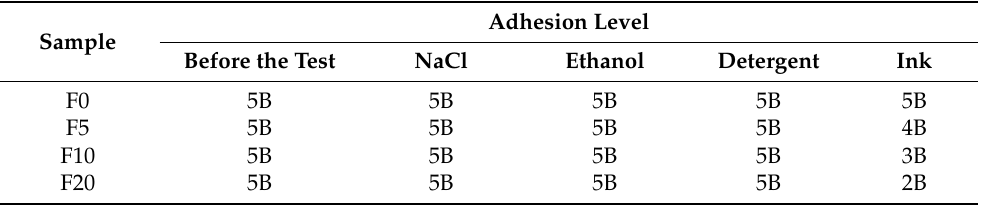
Table 4. Cross Cut Test results before and after the liquid resistance test.